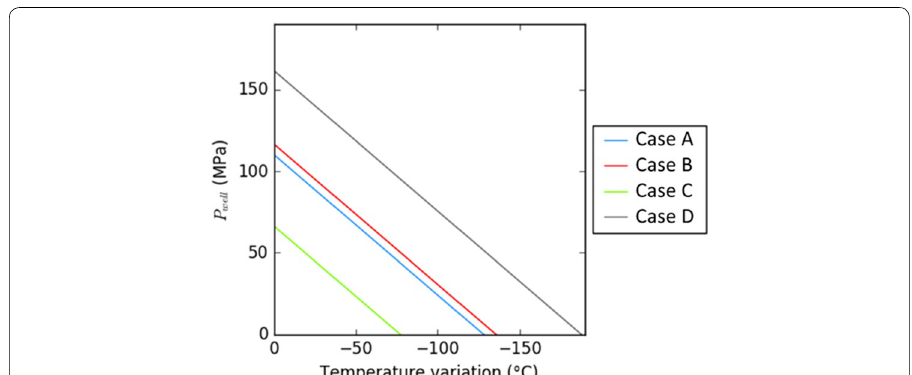
Fig. 14 Failure pressure ( P well ) versus temperature variation computed from Eq. 14 for the four cases. (Parameters: dolerite linear thermal expansion coefficient α Poisson ration ν 0.17 and UTS 15 = =